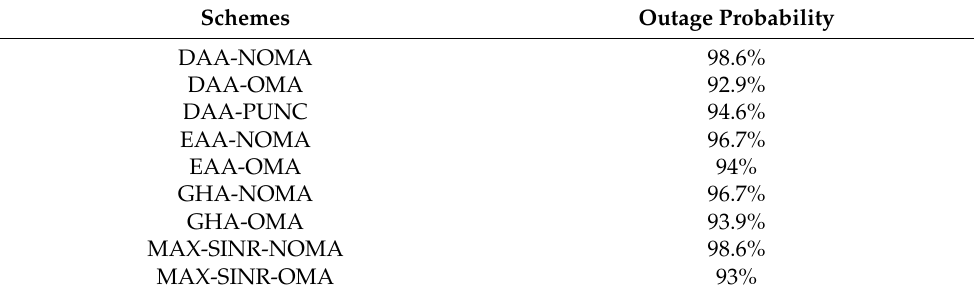
Figure 9. The outage-probability for eMBB UEs versus number of eMBB UEs. Table 6. Outage Probability for eMBB Traffic.